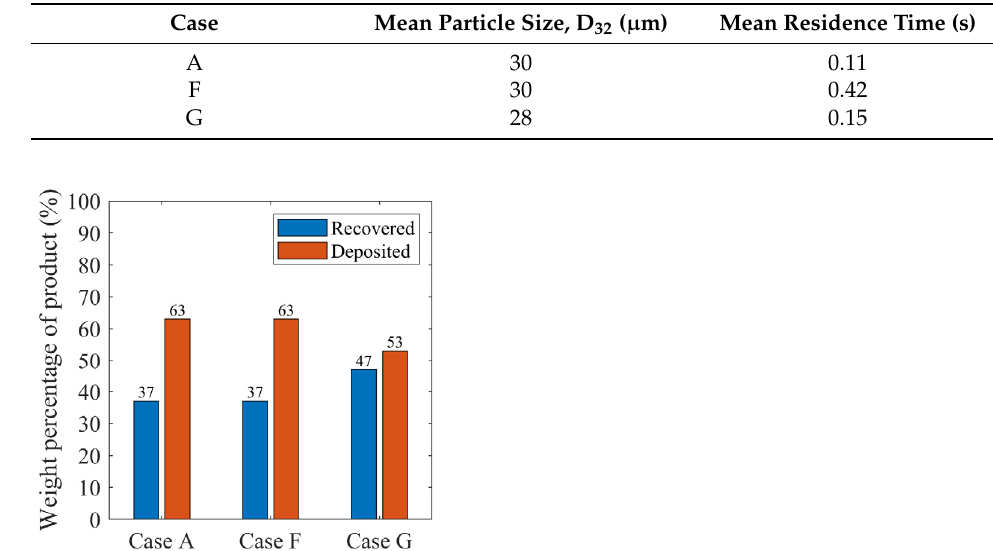
Figure 14. Normalized evaporation rates ( left ), and average particle diameters ( right ) along the axial height of the dryer for cases A, F and G (location of atomizer = 0). Table 6. Particle mean diameter and mean residence time at outlet. Table 6. Particle mean diameter and mean residence time at outlet.